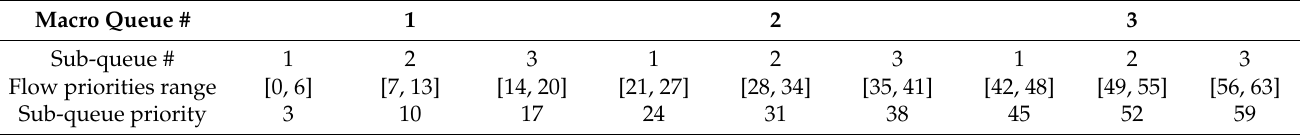
Table 4. Three macro-queues’ sub-queue priorities.